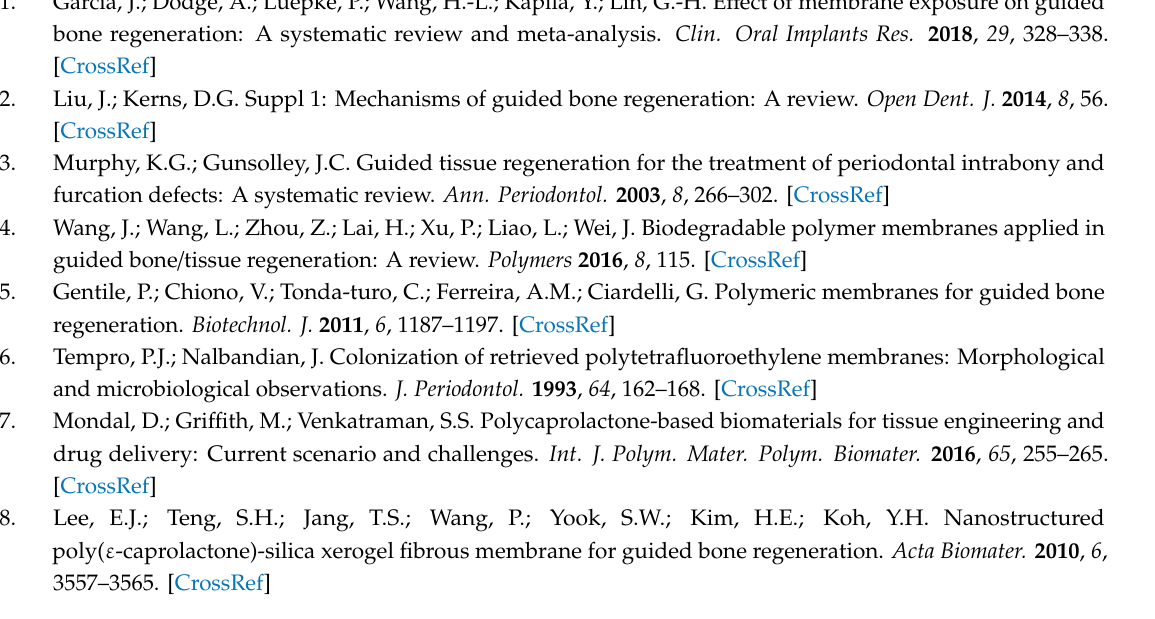
Figure S5. Loading-unloading indentation curves of PCL and its composite